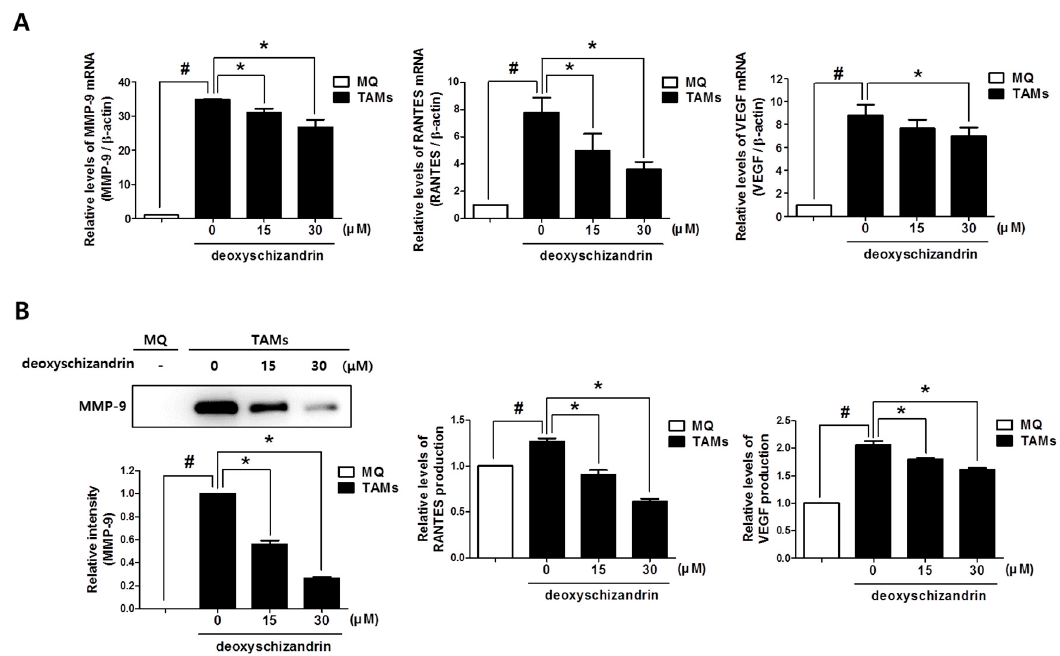
Figure 7. Effect of deoxyschizandrin on the mRNA expression and production of MMP-9, RANTES, and VEGF in tumour-associated macrophages (TAMs); THP-1 cells were stimulated with conditioned medium from A2780 cells and were treated with the indicated concentration of deoxyschizandrin (15 and 30 µM) for 48 h. ( A ) Real-time RT-PCR was conducted to measure the mRNA levels of MMP-9, RANTES, and VEGF in macrophages; ( B ) Western blot analysis was performed to measure the production levels of MMP-9 in cell culture media. Band images are representatives of three individual experiments and the results of densitometry represent the mean ± SD of three independent experiments. Production levels of RANTES and VEGF in cell culture media were measured using ELISA assay. The values represent the mean ± SD of results from three independent experiments. # p < 0.05 vs. MQ; * p < 0.05 vs. the untreated TAMs.